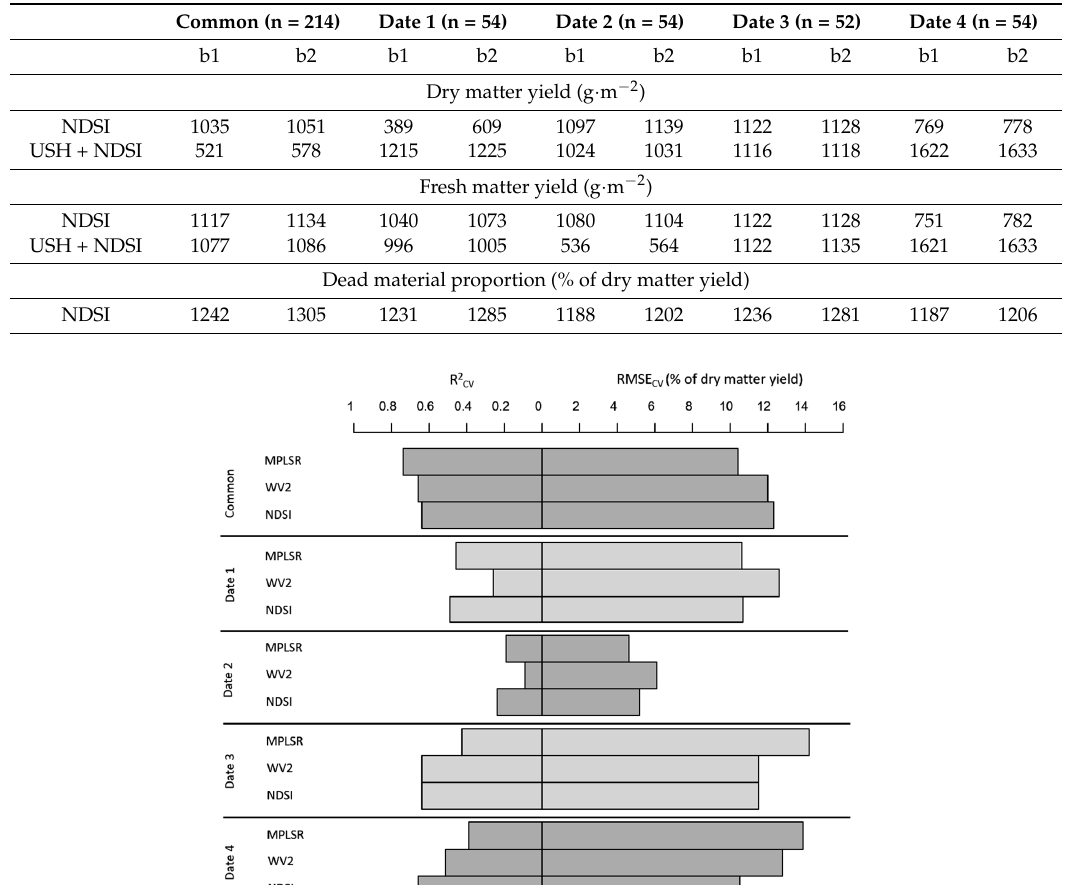
Table 2. Wavelength position of best-fit band combination (b1, b2) for the normalized difference spectral index (NDSI) exclusively and in combination with ultrasonic sward height (USH) predicted target parameter.